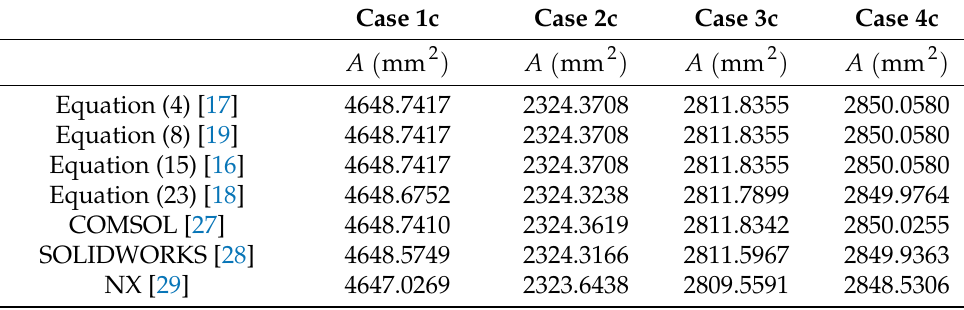
Table 7. Summary of results for intersection areas.